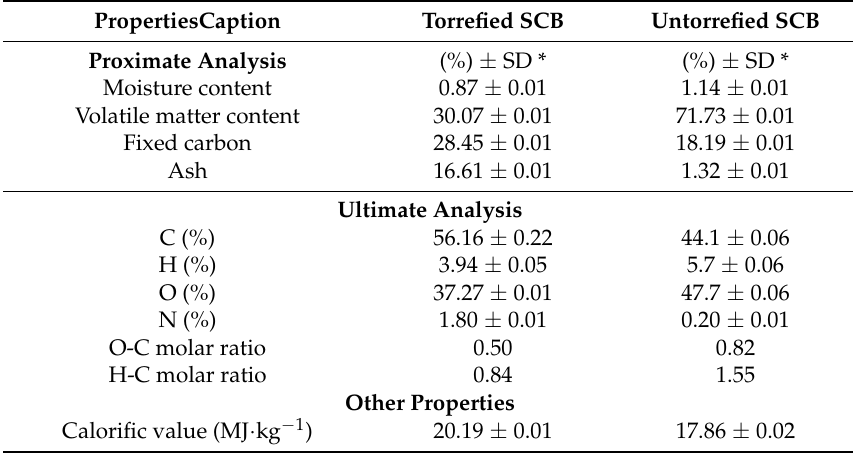
Table 2. Measured key characteristics of torrefied and untorrefied